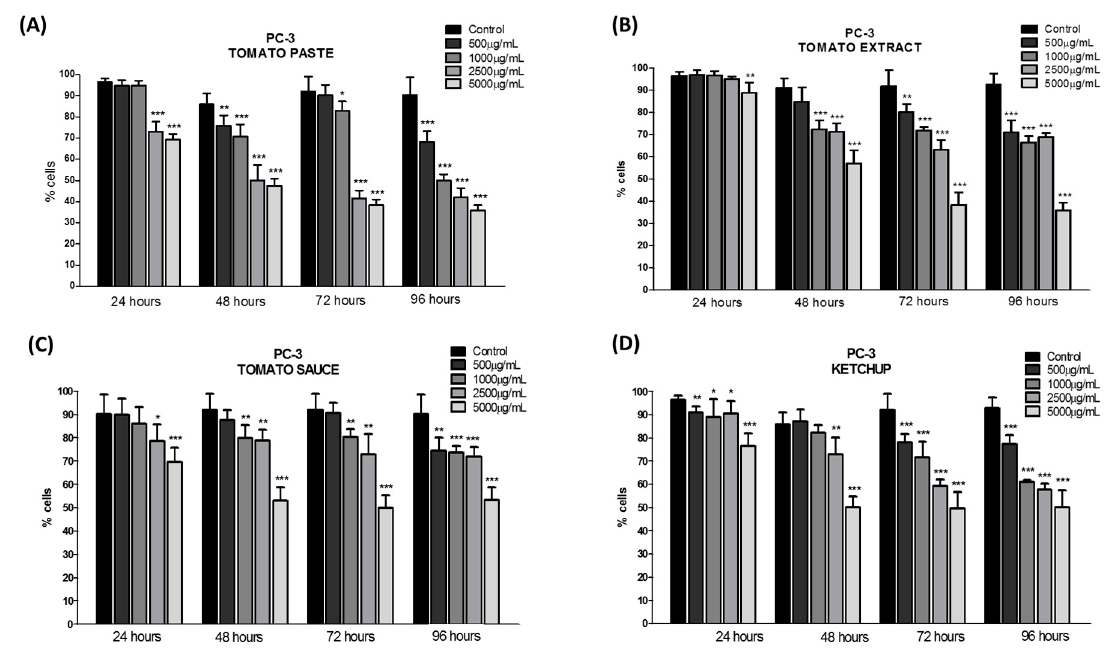
Figure 2. Effect of lycopene obtained of the tomato paste ( A ), tomato extract ( B ), tomato sauce ( C ), and ketchup ( D ) on DU-145 cell viability after 24, 48, 72, and 96 h of exposure, respectively. The results are expressed as mean ± error standard and significant differences between untreated cells (Control) and those treated with lycopene (500, 1000, 2500, and 5000 μ g/mL) were compared by one-way ANOVA followed by Tukey’s multiple comparison post-hoc test. * p < 0.05; ** p < 0.01; *** p < 0.001.